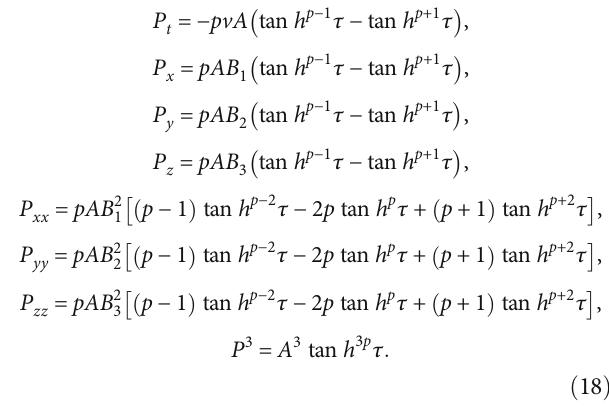
Figure 1: (Color online) The solitary wave solution (13) of Equation (1) with suitable parameters: a = 3 , b = ffiffiffi p 2 . (a) Perspective view of the solitary wave solution of the real part. (b) The overhead view (density plot) of the solitary y = z = 0 , and n = − wave solution of the real part. (c) The wave propagation pattern of the wave along the x -axis of the real